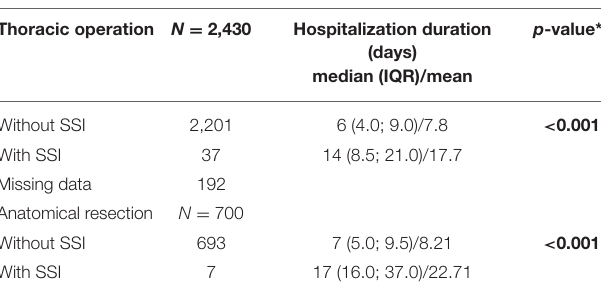
TABLE 4 | Comparison of hospitalization duration for 2,430 patients undergoing thoracic operation and for 700 patients undergoing anatomical resection according to